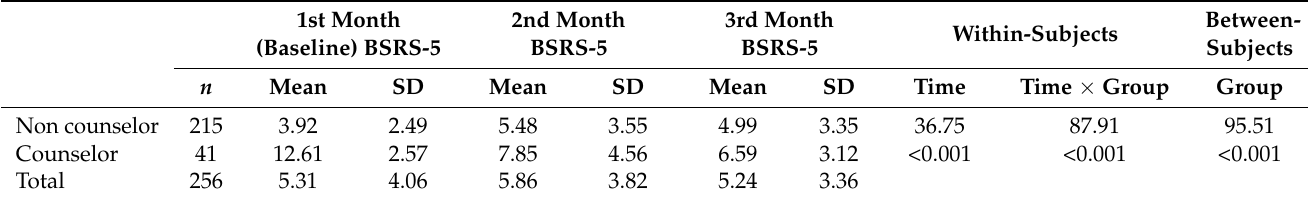
Table 4. Variate analysis of the professional knowledge scores for NGNs receiving gentle care and counseling .